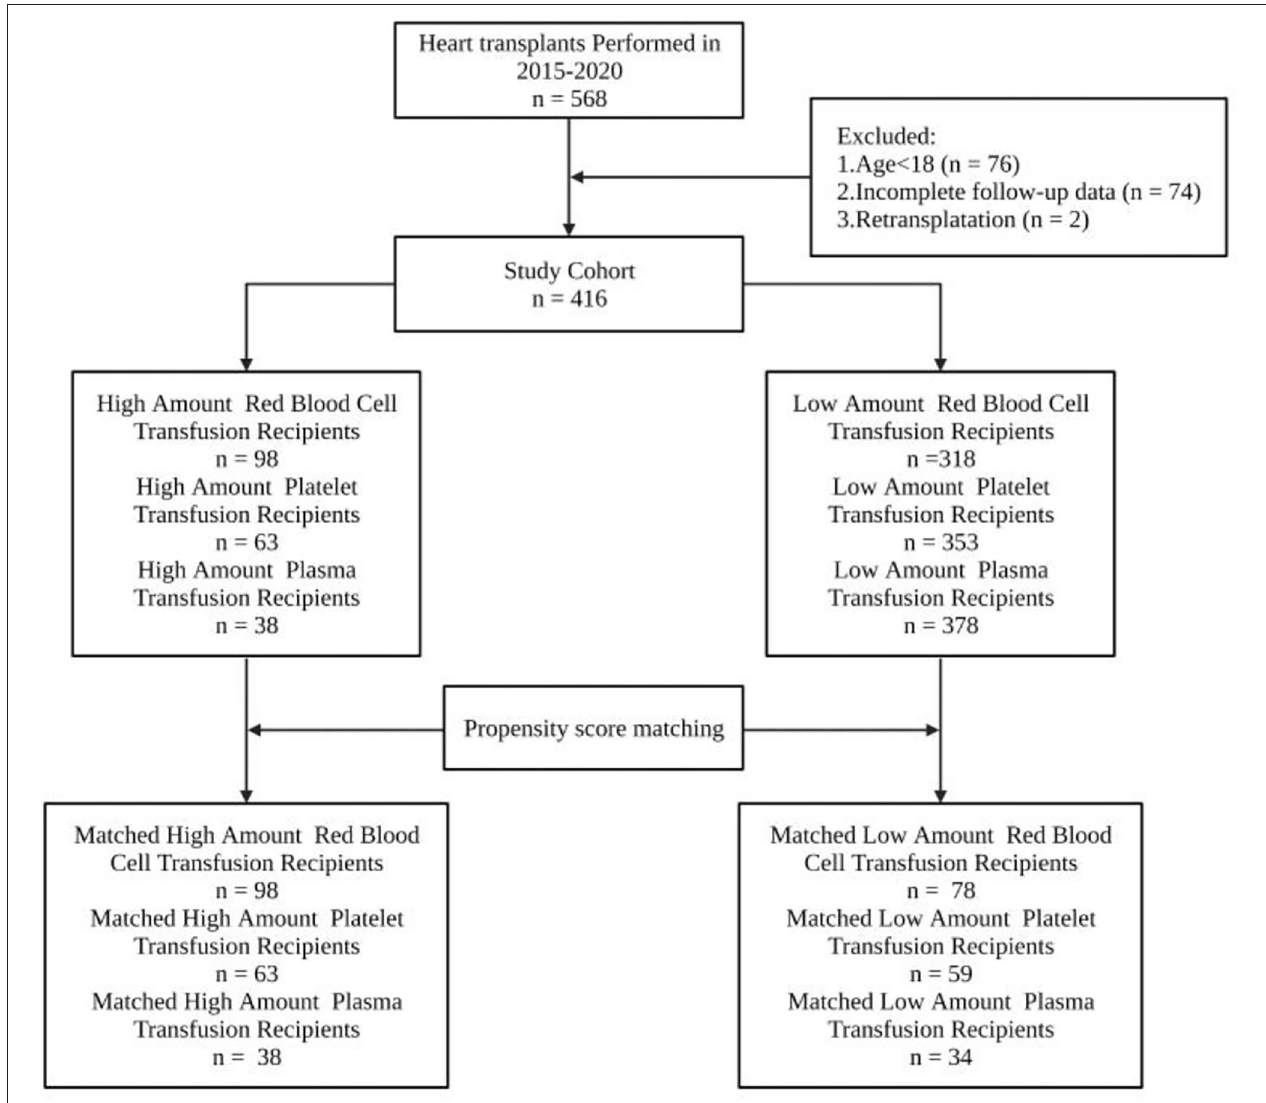
FIGURE 1 | All 568 cardiac transplant patients at Wuhan Union Hospital from January 2015 to December 2020 were recruited. Patients with ages under 18 years, umpteen incomplete follow-up and transfusion data, or receiving retransplant were excluded from the study. Among the 568 recipients, 76 were under the age of